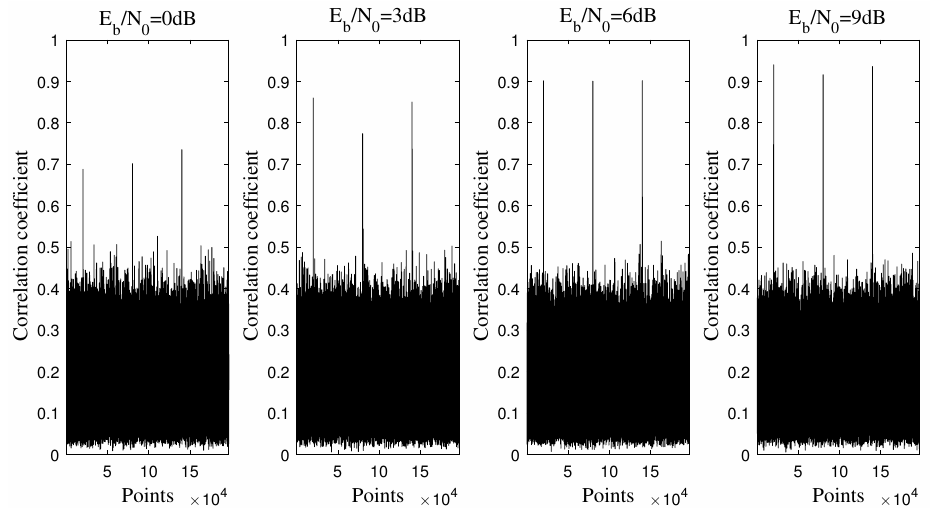
Figure 9. The correlation coefficient curves obtained by DUWDC in the case of f e T =